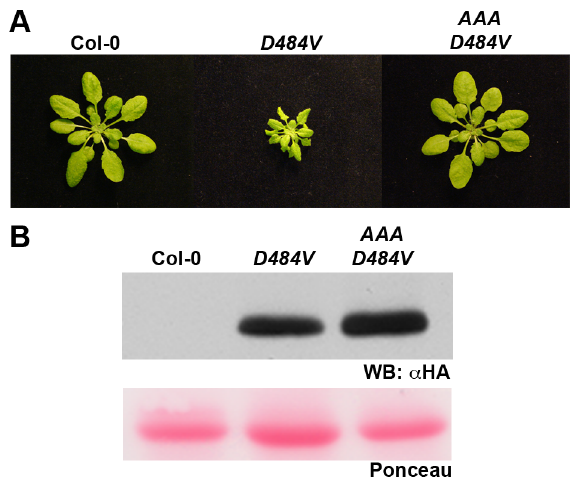
Figure 5. An intact P-loop catalytic domain is required for the ADR1-L2 D484V morphological phenotype. (A) Pictures of five-week- old Col-0, ADR1-L2 D484V , and ADR1-L2 AAA D484V plants show relative morphology. (B) Western blot of Col-0 and HA-tagged ADR1-L2 D484V and ADR1-L2 AAA D484V protein from plants in (A). Relative loading indicated by Ponceau stained blot.